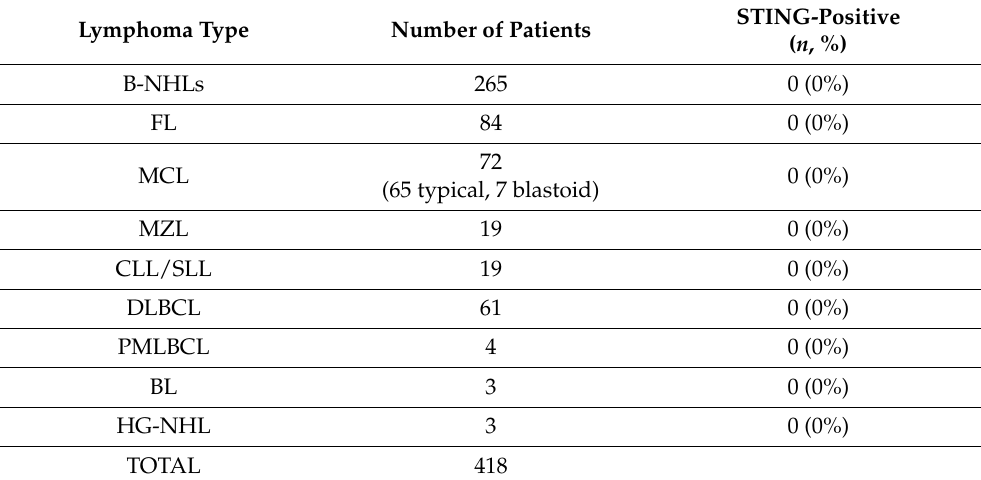
Table 1. Cont . Lymphoma Type